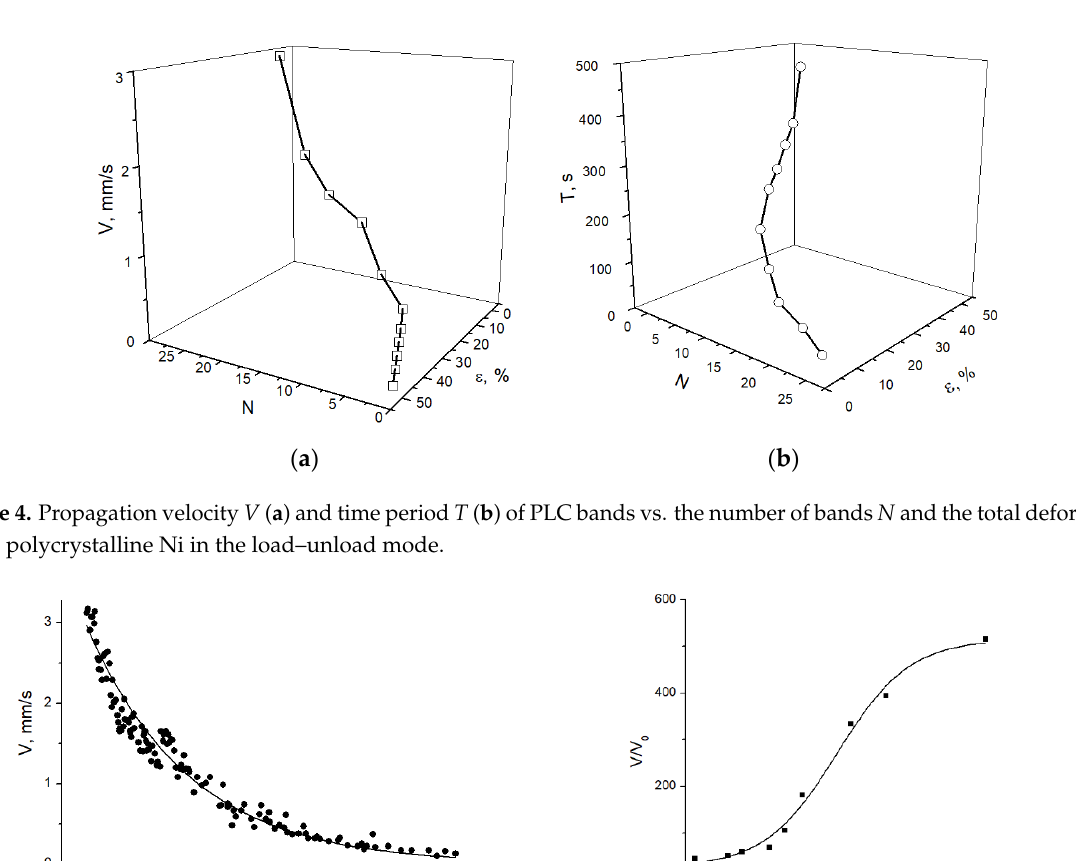
Figure 4. Propagation velocity V ( a ) and time period T ( b ) of PLC bands vs. the number of bands N